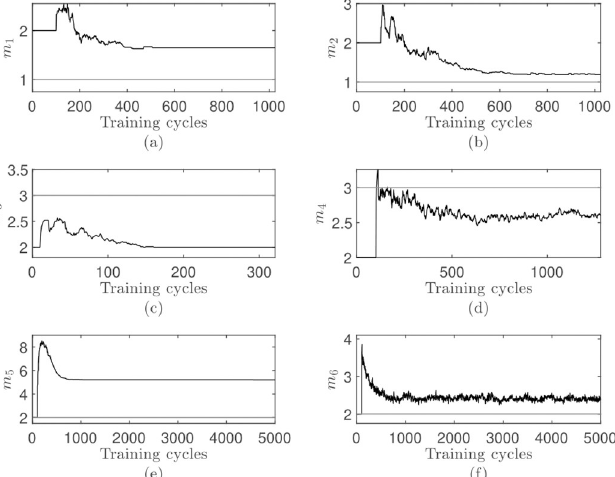
Fig 6. Visualization of the dimensionality adjustment process for the online eigenvalue-average criterion applied on the presented data sets (Table 1): (a-f) Adjustment process corresponds to the results in Table 3. Each data point in each time series is the mean value of all 100 repetitions. The horizontal reference line represents the optimal dimensionality.